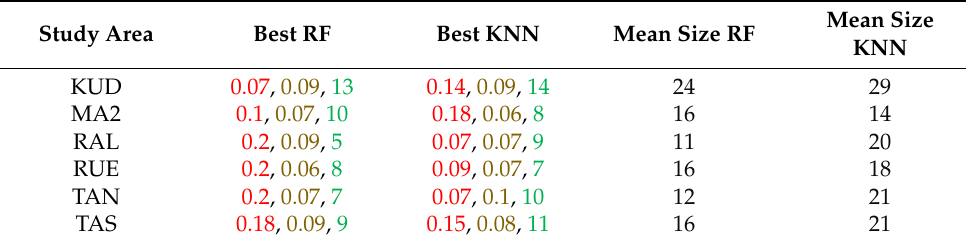
Table 4. Best parameters for segmentations after applying the GA for each classifier (Best RF and Best KNN) and mean size of segments (pixels) for each classifier in the study areas. The parameters are Spectral Range (red, reflectance units), Spatial Range (brown, in meters) and Minimum Size (green, pixels).